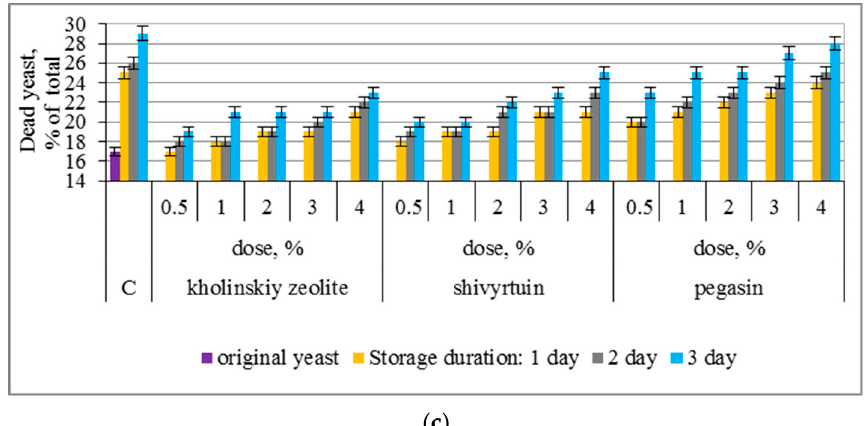
Figure 3. Changes in the physiological parameters of yeast culture stored in young beer with natural ZT (C—control sample, 0.5–4% values—dose of zeolite-containing tuffs): ( a ) the number of yeast cells with glycogen; ( b ) the number of budding yeast cells; ( c ) the number of dead yeast cells; ( p ≤ 0.05). In the experimental samples, the number of cells with glycogen and that of the bud- ding cells was 1.2–1.4 times higher than the initial value (on average). The control sample was characterized by an 8% increase in the number of cells with glycogen and a sharp 77% decrease in the number of budding cells compared to the initial value.